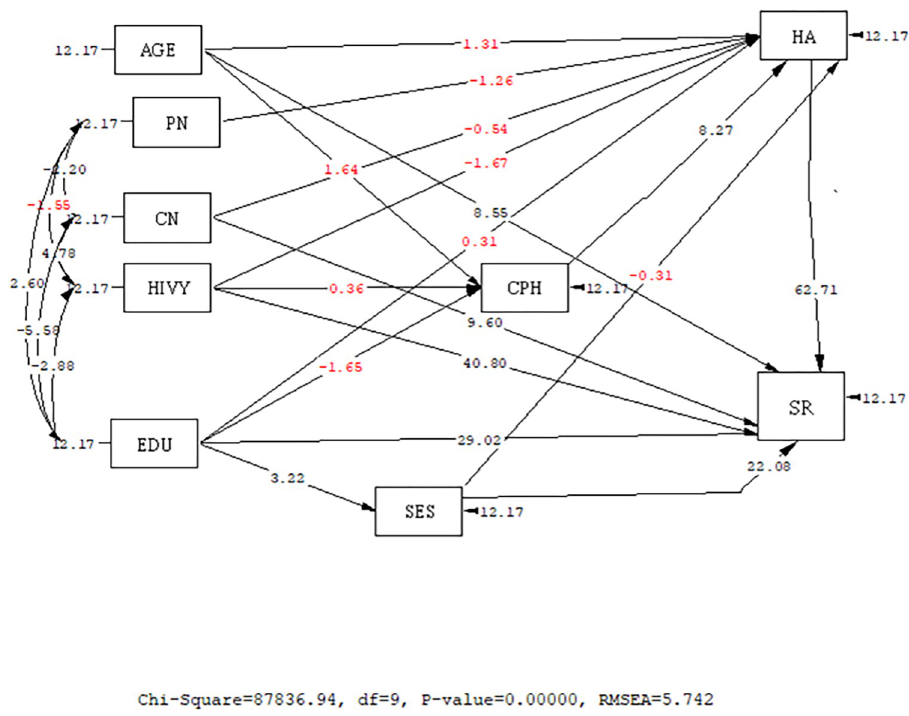
Fig 1. Full empirical path model between health anxiety, COVID-19 phobia, and social relationsaccording to T- value. (T-value > 1.96 is considered as significant). AGE: Age, PN: Partner number, CN: Child number, HA: Health anxiety, HIVY = HIV duration (year), SES: Socioeconomic status; EDU: Education, SR: Social relations; CPH: COVID-19 phobia.